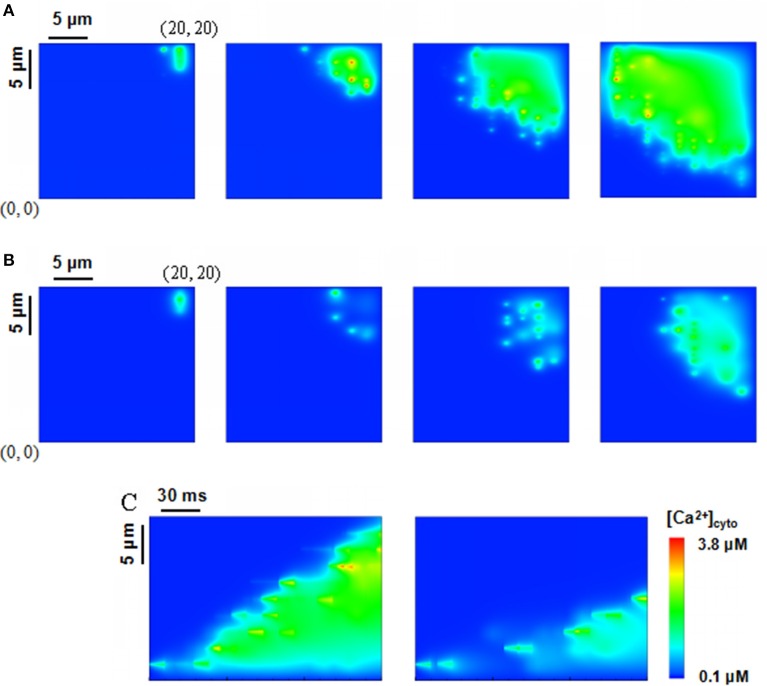
Ca2+ waves triggered by four sparks at the corner of a computational domain, i.e., (18, 19.2), (18, 18.4), (18, 17.6), (18, 16.8) in the region of 20 × 20 μm2. The beginning level of [Ca2+]lumen is 1.0 mM. (A,B) Snapshots of Ca2+ waves initially triggered by Ca2+ sparks with rogue RyRs (A) and without considering rogue RyRs (B) at 10, 50, 100, 150 ms from left to right. (C) Computational results for line-scan images of [Ca2+]cyto with and without rogue RyRs at the line of y = 16.8.